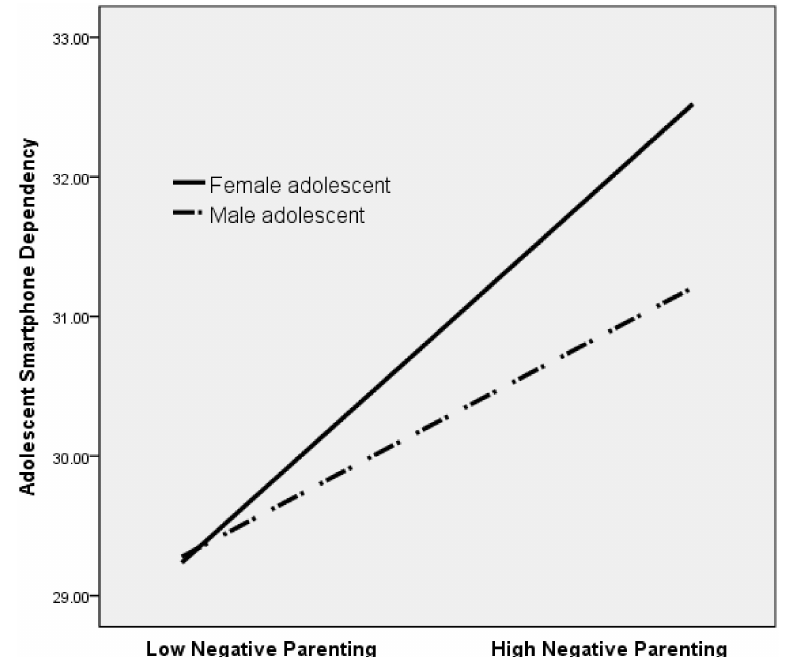
Figure 3. Moderation of the e ff ect of negative parenting on adolescent smartphone dependency by